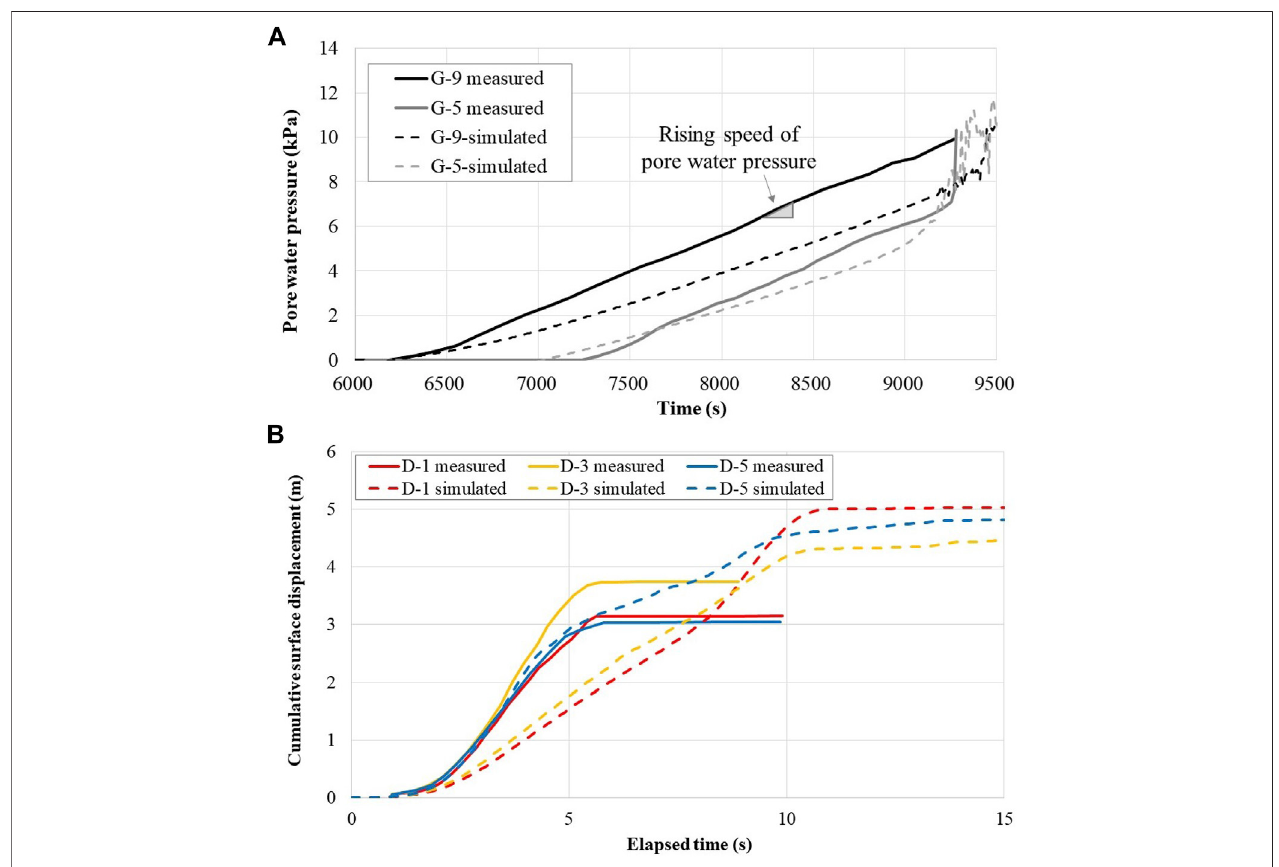
FIGURE 6 | Comparison of the measured and simulated results: (A) Evolution of pore water pressure at G-5 and G-9; (B) Evolution of cumulative surface displacement at D-1, D-3, and D-5.